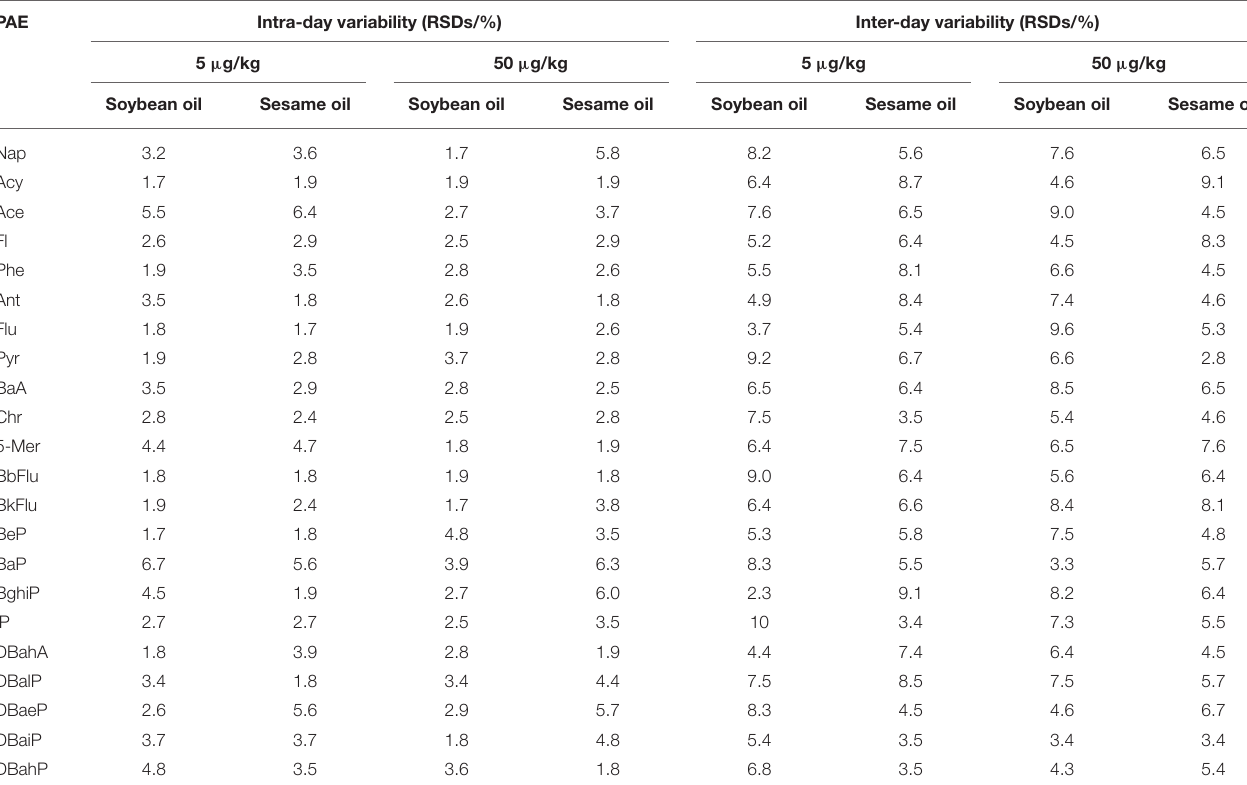
TABLE 3 | Precision of the method in soybean oil and sesame oil at levels of 5 and 50 µ g/kg. PAE Intra-day variability (RSDs/%) Inter-day variability